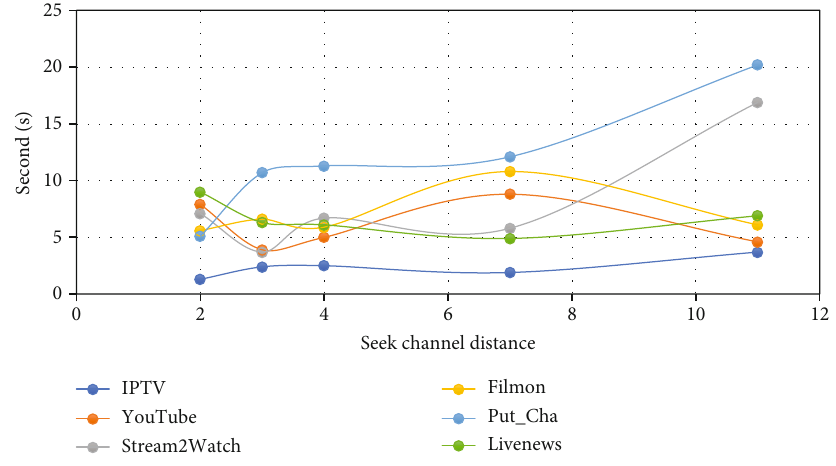
Figure 2: Time taken for channel